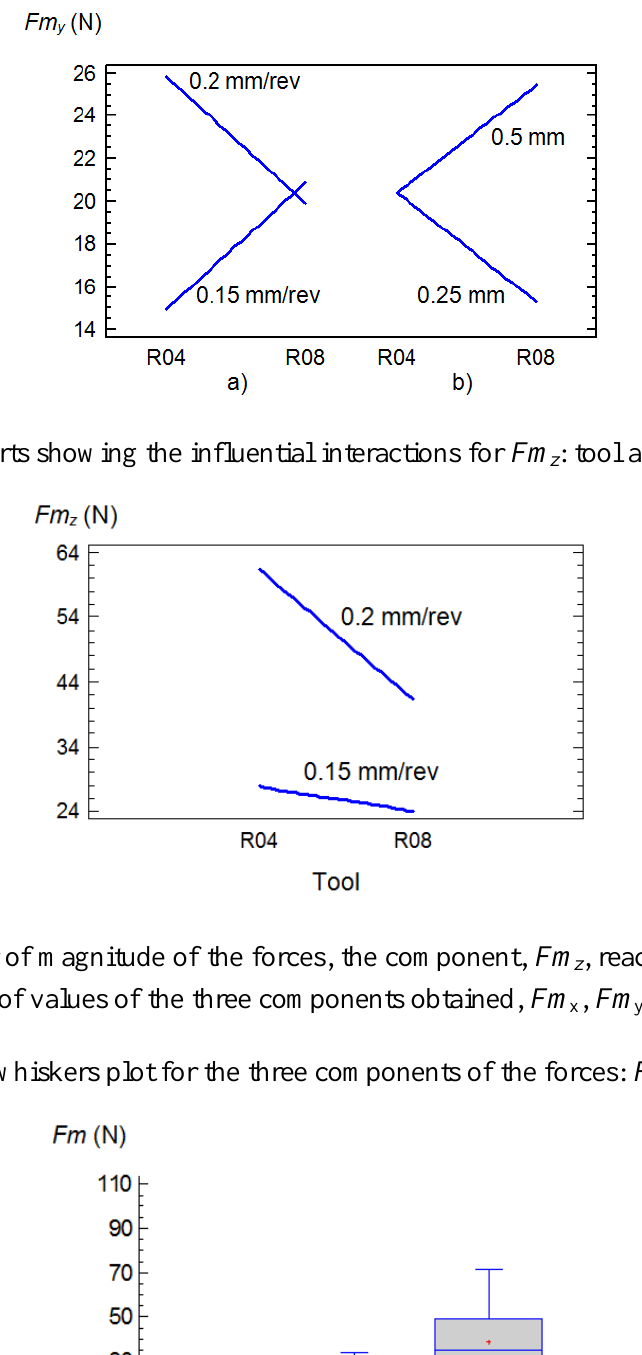
Figure 4. Charts showing the influential interactions for Fm and cutting depth.